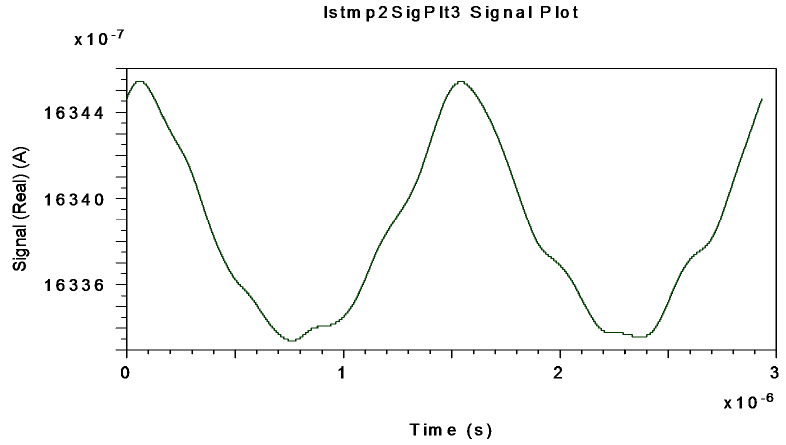
Figure 14. Interferometric current signal obtained at APD-equivalent-photodetector electrical output (after electrical BP Filter with f center = 340.83 kHz) when Ω = ±30 °/s is applied to system.